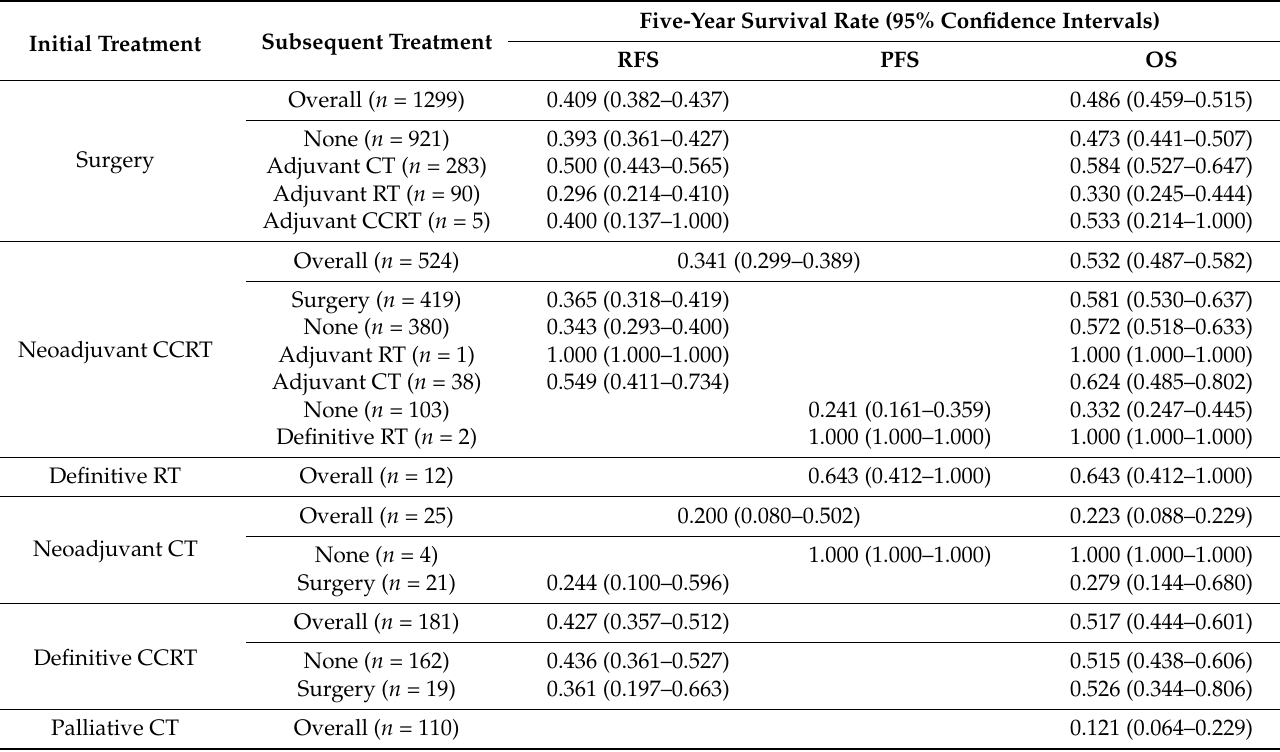
Table 2. Five-year survival rate according to treatment.